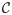
External complexity in artificial systems over time.The number of external configurations available, C, for mechanization in robot platforms over time. Several platforms have an assumed positioning resolution of 0.1° and an estimated range of motion. Some platform names are omitted for clarity; see S1 Appendix for full list.